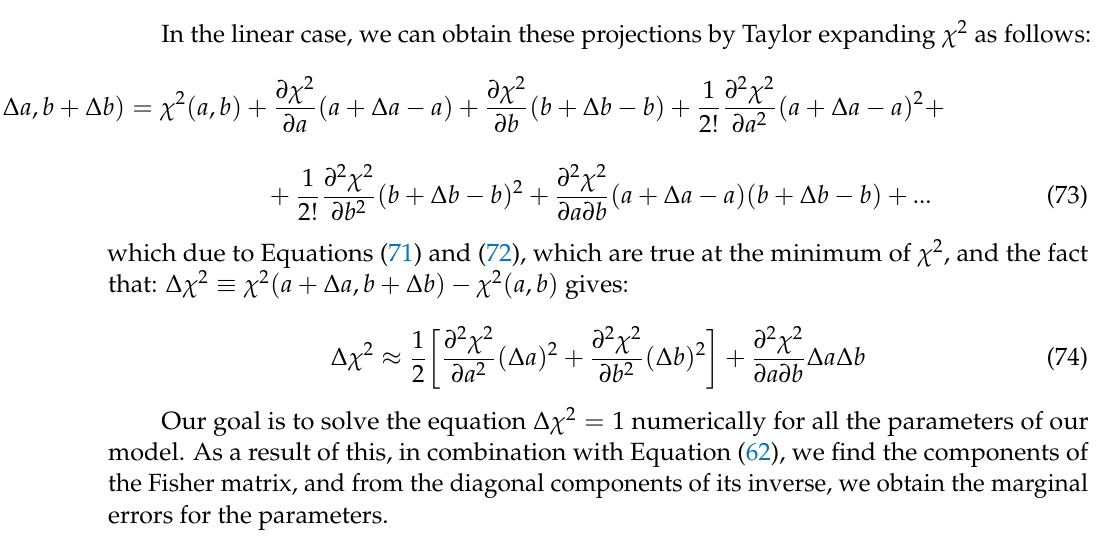
Figure 13. Standard errors for the parameters a and b found as the projections of the ellipse, which is the confidence region boundary with ∆ χ 2 = 1, on the a and b axes. Adapted from: